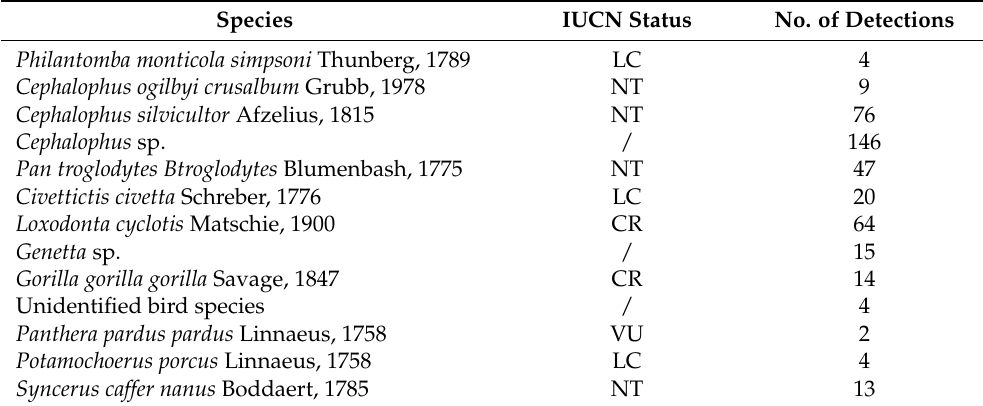
Table A6. List of detected species with the IUCN status (‘Least Concern’ [LC], ‘Near Threatened’ [NT], ‘Vulnerable’ [VU], ‘Endangered’ [EN], or ‘Critically Endangered’ [CR]), and number of detections by species.